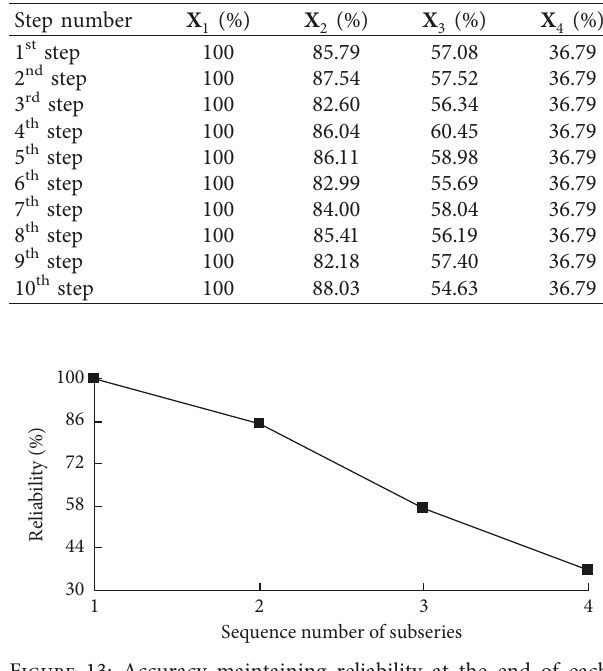
Table 5: Accuracy maintaining reliability for the subseries at each step.